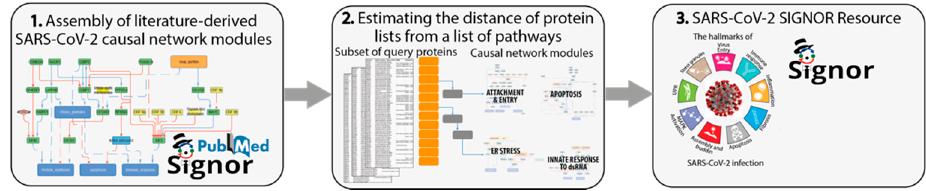
Figure 2. Scheme of the causal network-based strategy. The three frames enclose illustrations of the three steps used in the strategy. (1) Assembly of SARS-CoV-2 causal network and identification of functional modules. (2) Development of a graph algorithm to estimate the “functional distance” of a query list from cellular pathways that are relevant for SARS-CoV-2 infection. (3) Organize the results of this approach in a publicly available online resource.